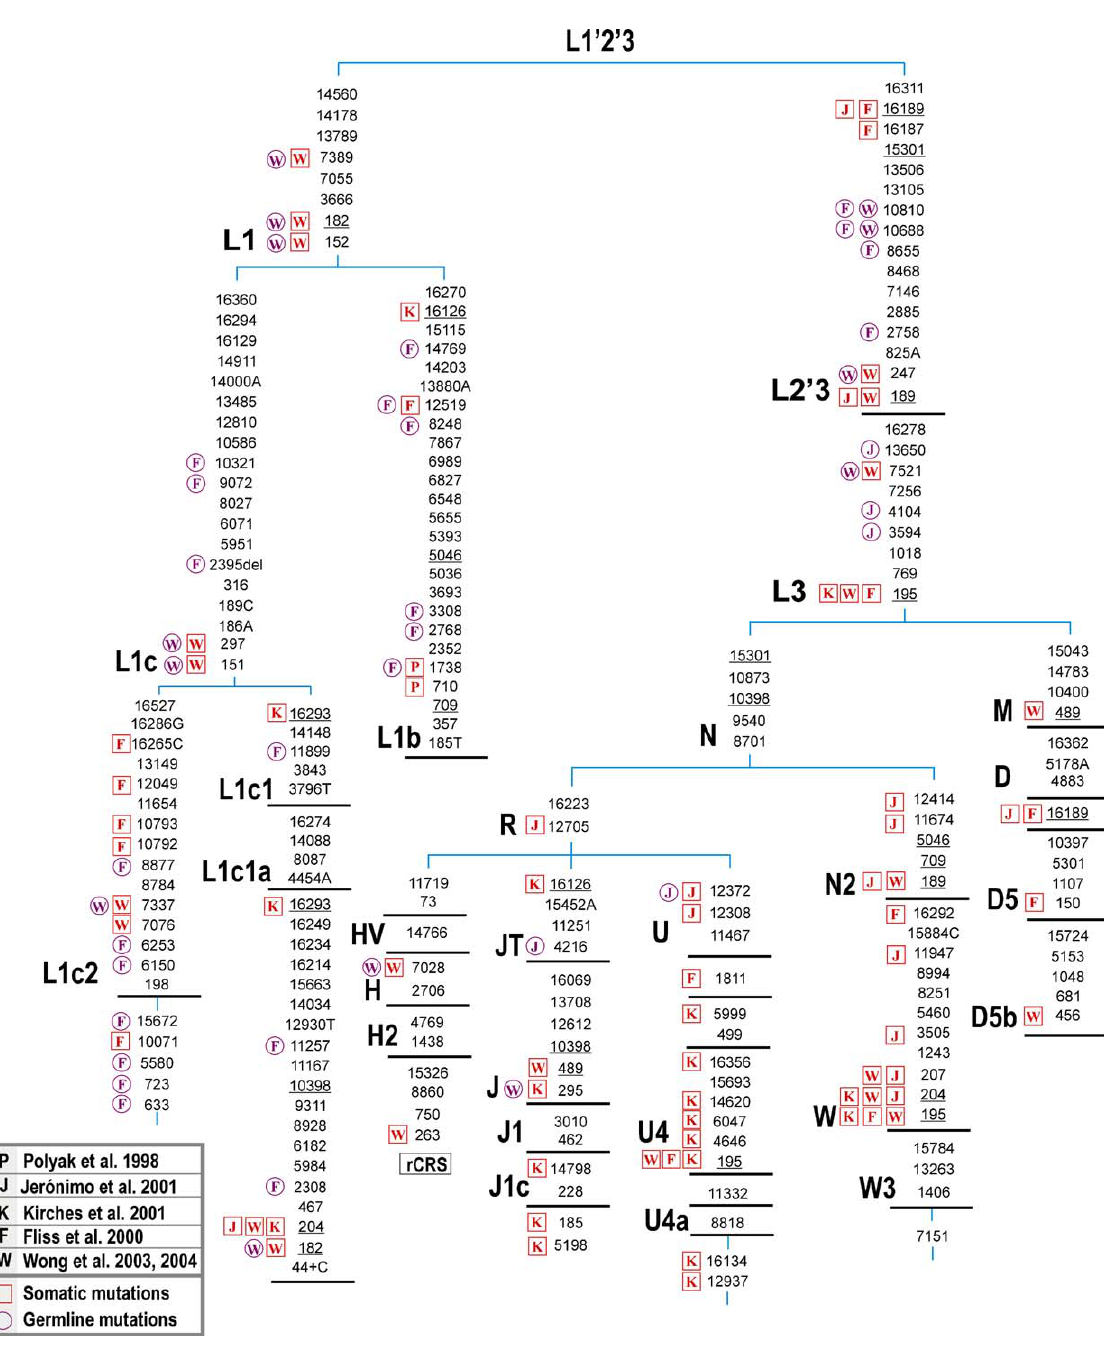
Figure 1. Portion of the Worldwide mtDNA Phylogeny That Explains the Most Relevant Contamination/Sample Mix-Up Episodes Erroneously Interpreted as mtDNA Instabilities in Several Kinds of Tumors or Detected as Germline Mutations, as Commented in the Text Capital letter-number codes designate haplogroups; bold bars indicate intermediate branching points as inferred from the total mtDNA phylogeny. Variation at position 16519, length polymorphisms of long C-stretches in HVS-I and II, and dinucleotide repeats at 522–523 are disregarded. All mutations are transitions except for those suffixed by A, G, C, or T (transversion) or del (deletion) or þ (insertion of the specified nucleotide). Parallel mutations are underlined. Somatic (red squares) and germline (pink circles) mutations are indicated on the left side of each position in the tree as they appear in their original studies. DOI: